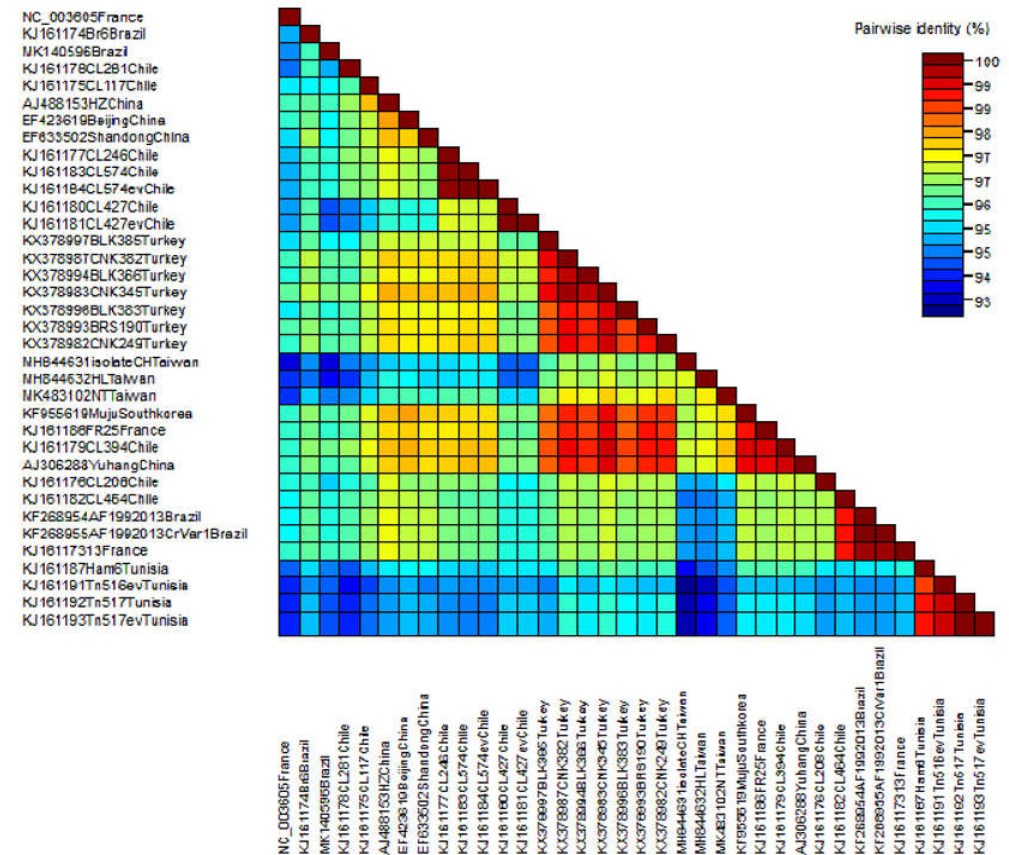
Fig. 2. Two-dimensional pairwise sequence identity color plot of the LMV